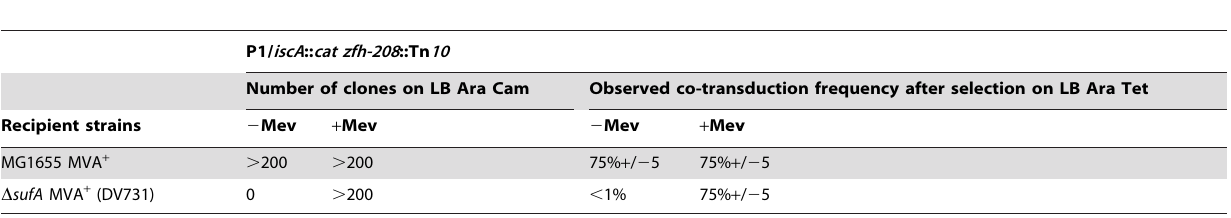
Table 2. iscA and sufA mutations are synthetically lethal under aerobiosis because of defective IPP biosynthesis.